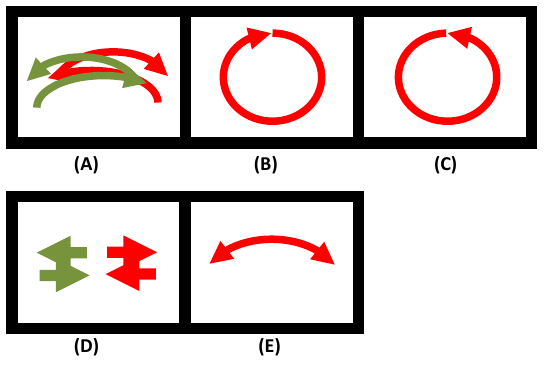
Figure 12. Gestures used for validation (swipe, clockwise circle, counter clockwise circle, hand clapping and no gestures).